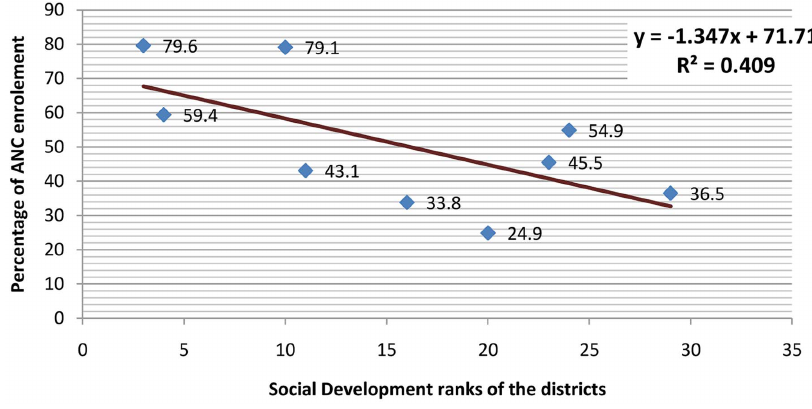
Figure 2. Association of Social Development Ranking with the District ANC coverage.